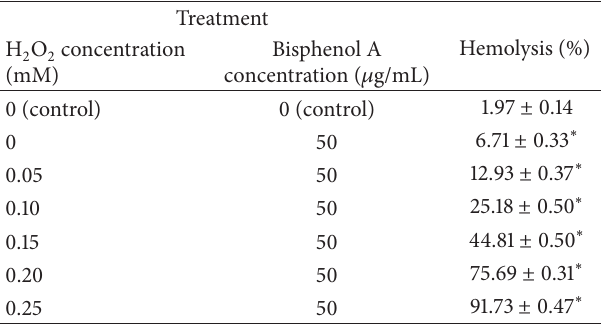
Table 3: H O induced hemolysis along with cotreatment of 2 2 bisphenol A.